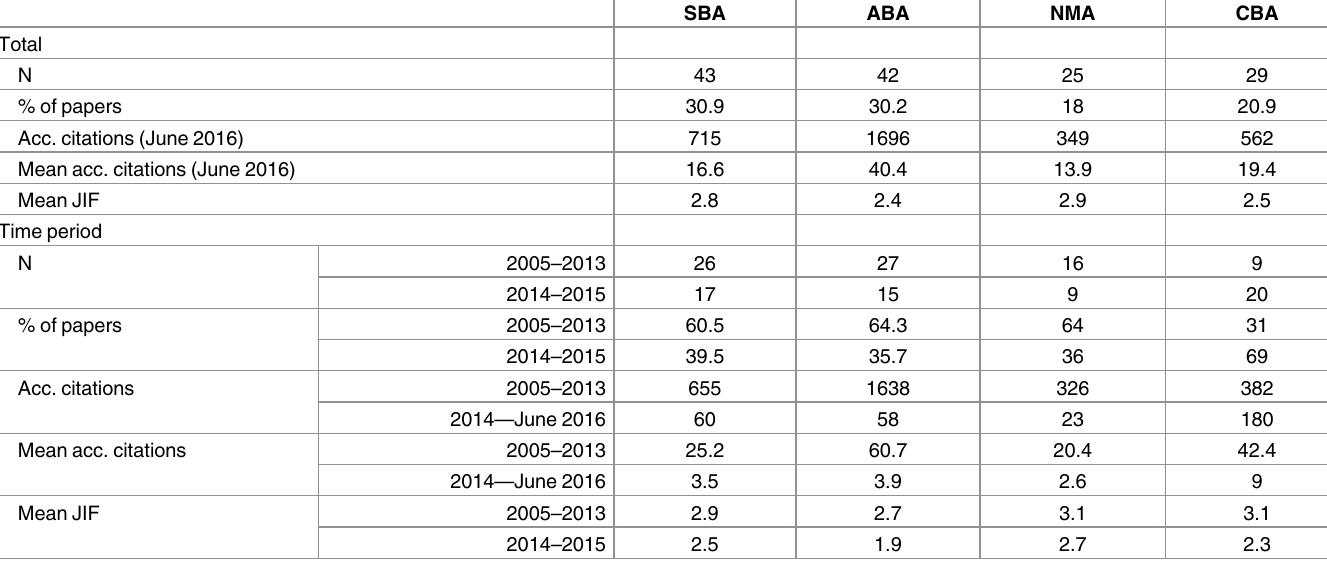
Table 2. Number of studies, percentages, accumulated citations, mean accumulated citations and mean impact factor, classified by paper cate- gory, and publication time